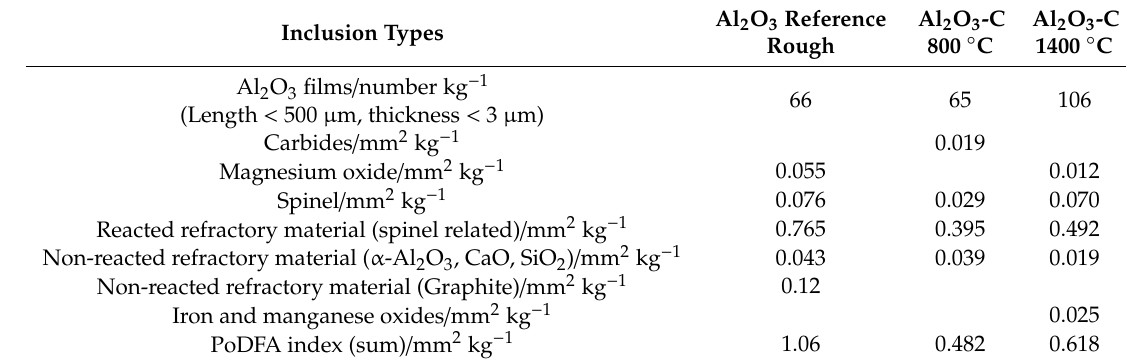
Table 4. Results of the PoDFA analysis of filtration trial 2, regarding the filtered melt. Inclusion Types